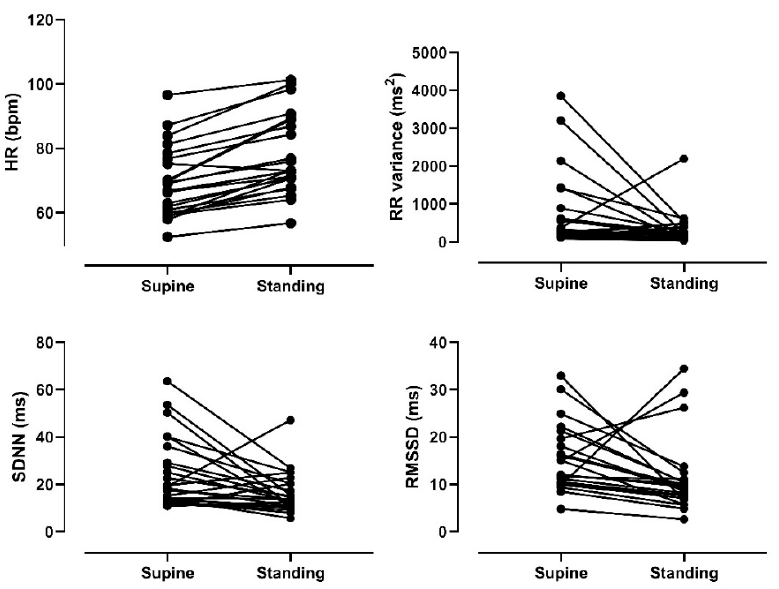
Figure 1. Time domain heart rate variability indices assessed at supine and standing postures. HR: heart rate. SDNN: standard deviation of normal-to-normal RR intervals. RMSSD: root mean square of successive differences in RR interval.